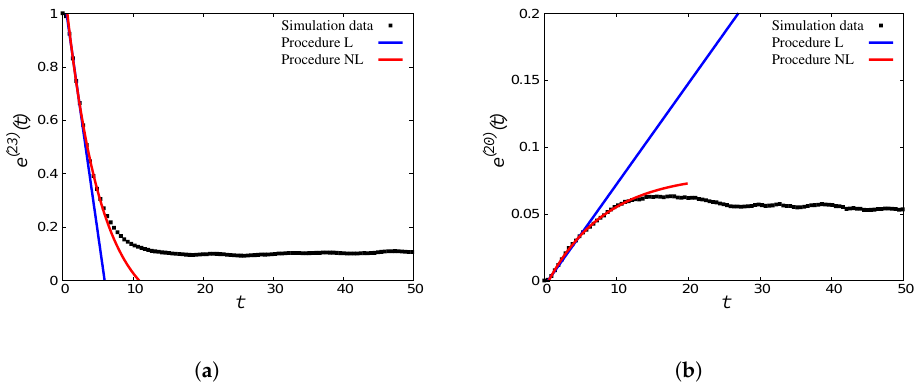
Figure 14. ( a ) Decaying binned total energy response of the initially agitated Bin 23 for k ins = 2.159 with the fits following the Linear (L) and Nonlinear (NL) procedures. ( b ) Increasing binned total energy response of Bin 20 receiving energy with the fits following the L and NL procedures. Only times from 2 ∆ t to 8 ∆ t were used for the linear fit and from 2 ∆ t to 18 ∆ t for the nonlinear fit, with ∆ t = 1.